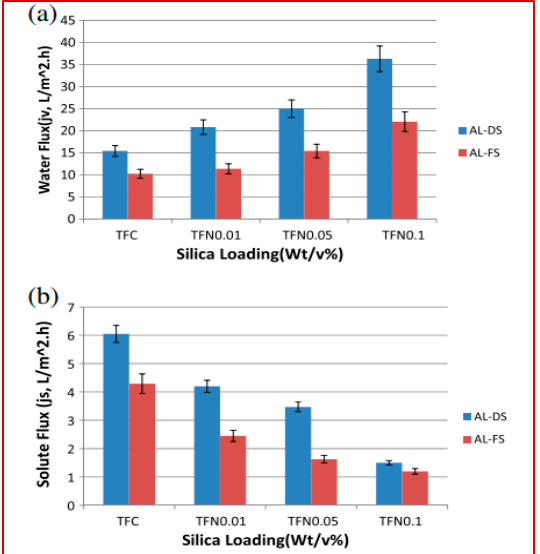
Figure 4. FO water flux ( a ) and solute flux ( b ) in synthesized FO membranes.[9].